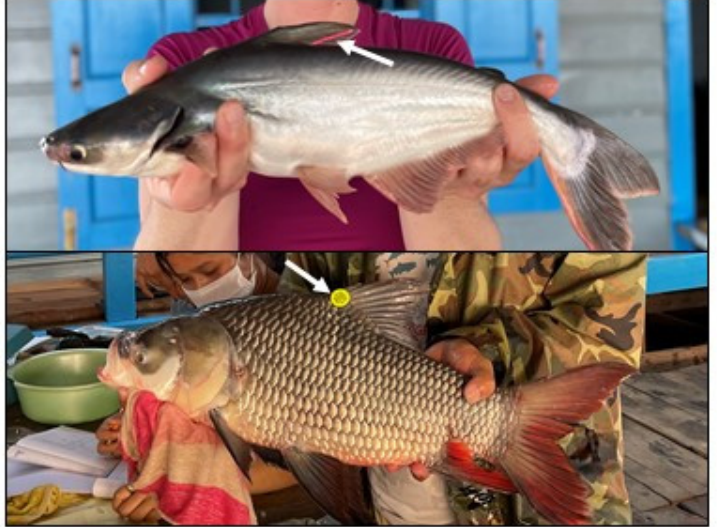
Figure 2. Types of tags used in the study. (Top) T-bar tag on a Pangasianodon hypophthalmus . (Bottom) Disc tag on a Catlocarpio siamensis .